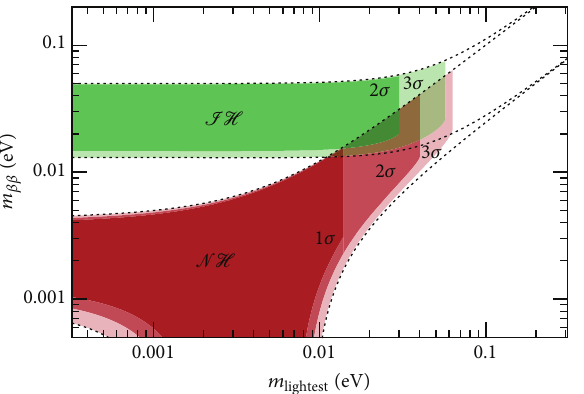
Figure 21: The plots show the allowed regions for 𝑚 𝛽𝛽 as a function of the neutrino cosmological mass Σ . The ellipses show the 90% CL regions in which a positive observation of 0 ] 𝛽𝛽 could be contained, according to the experimental uncertainties and 5 (solid) and 20 (dashed) actually observed events. In particular, the upper ellipse assumesthepresentlimitfromthecombined 136 Xeexperiments[81]. The lower one assumes the sensitivity of CUORE